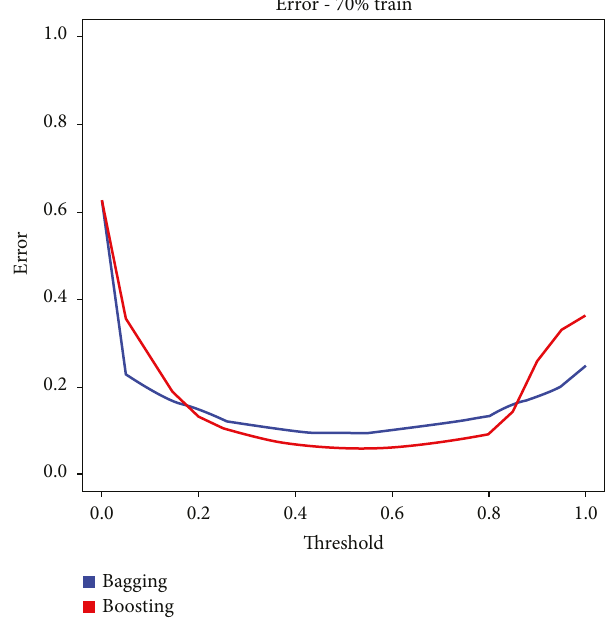
Figure 2: Total error of the models